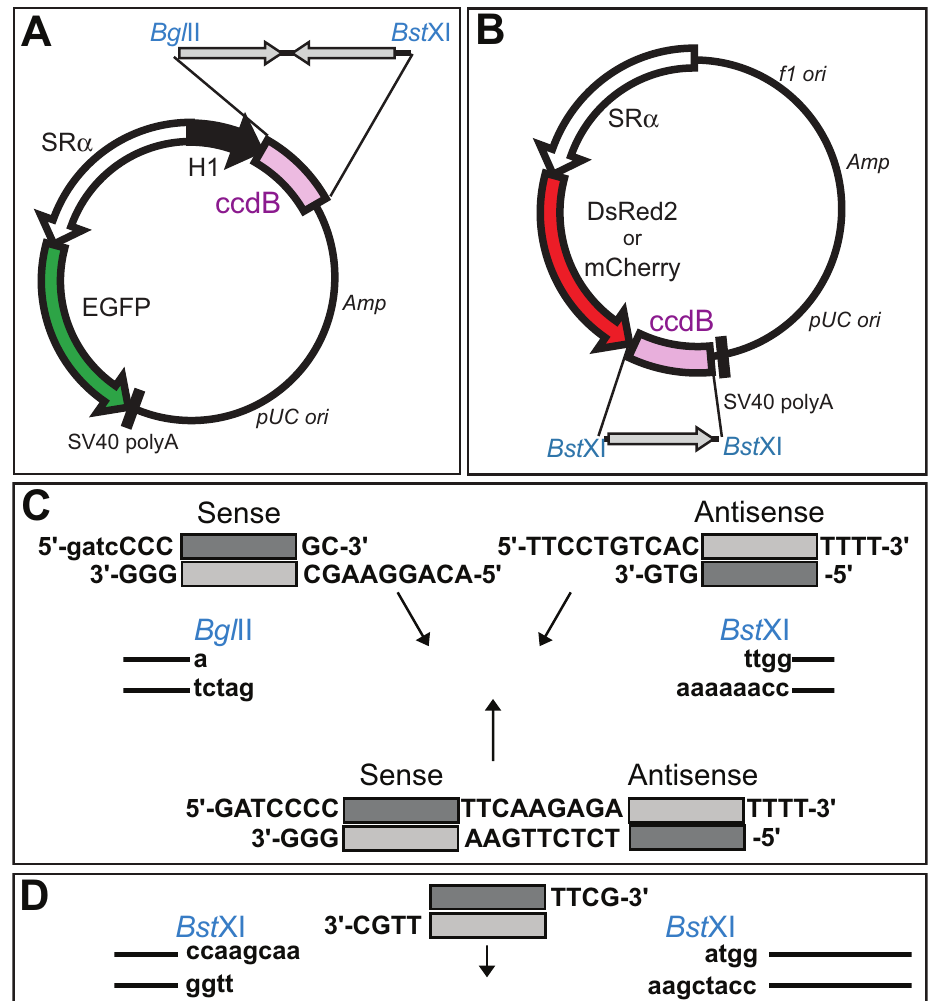
Supplemental Figure 7. Improved parental plasmid vectors containing the ccdB gene as a negative selection marker. ( A & B ) The ccdB cDNA was inserted to pSHIN-G ( A ) and pREFLECT-R ( B ). Annealed oligonucleotides are inserted into Bgl II- Bst XI and Bst XI- Bst XI gaps of pSHIN-G[ ccdB ] and pREFLECT-R[ ccdB ], respectively. ( C & D ) Detailed sequence information of the inserted oligonucleotides and the cloning sites is